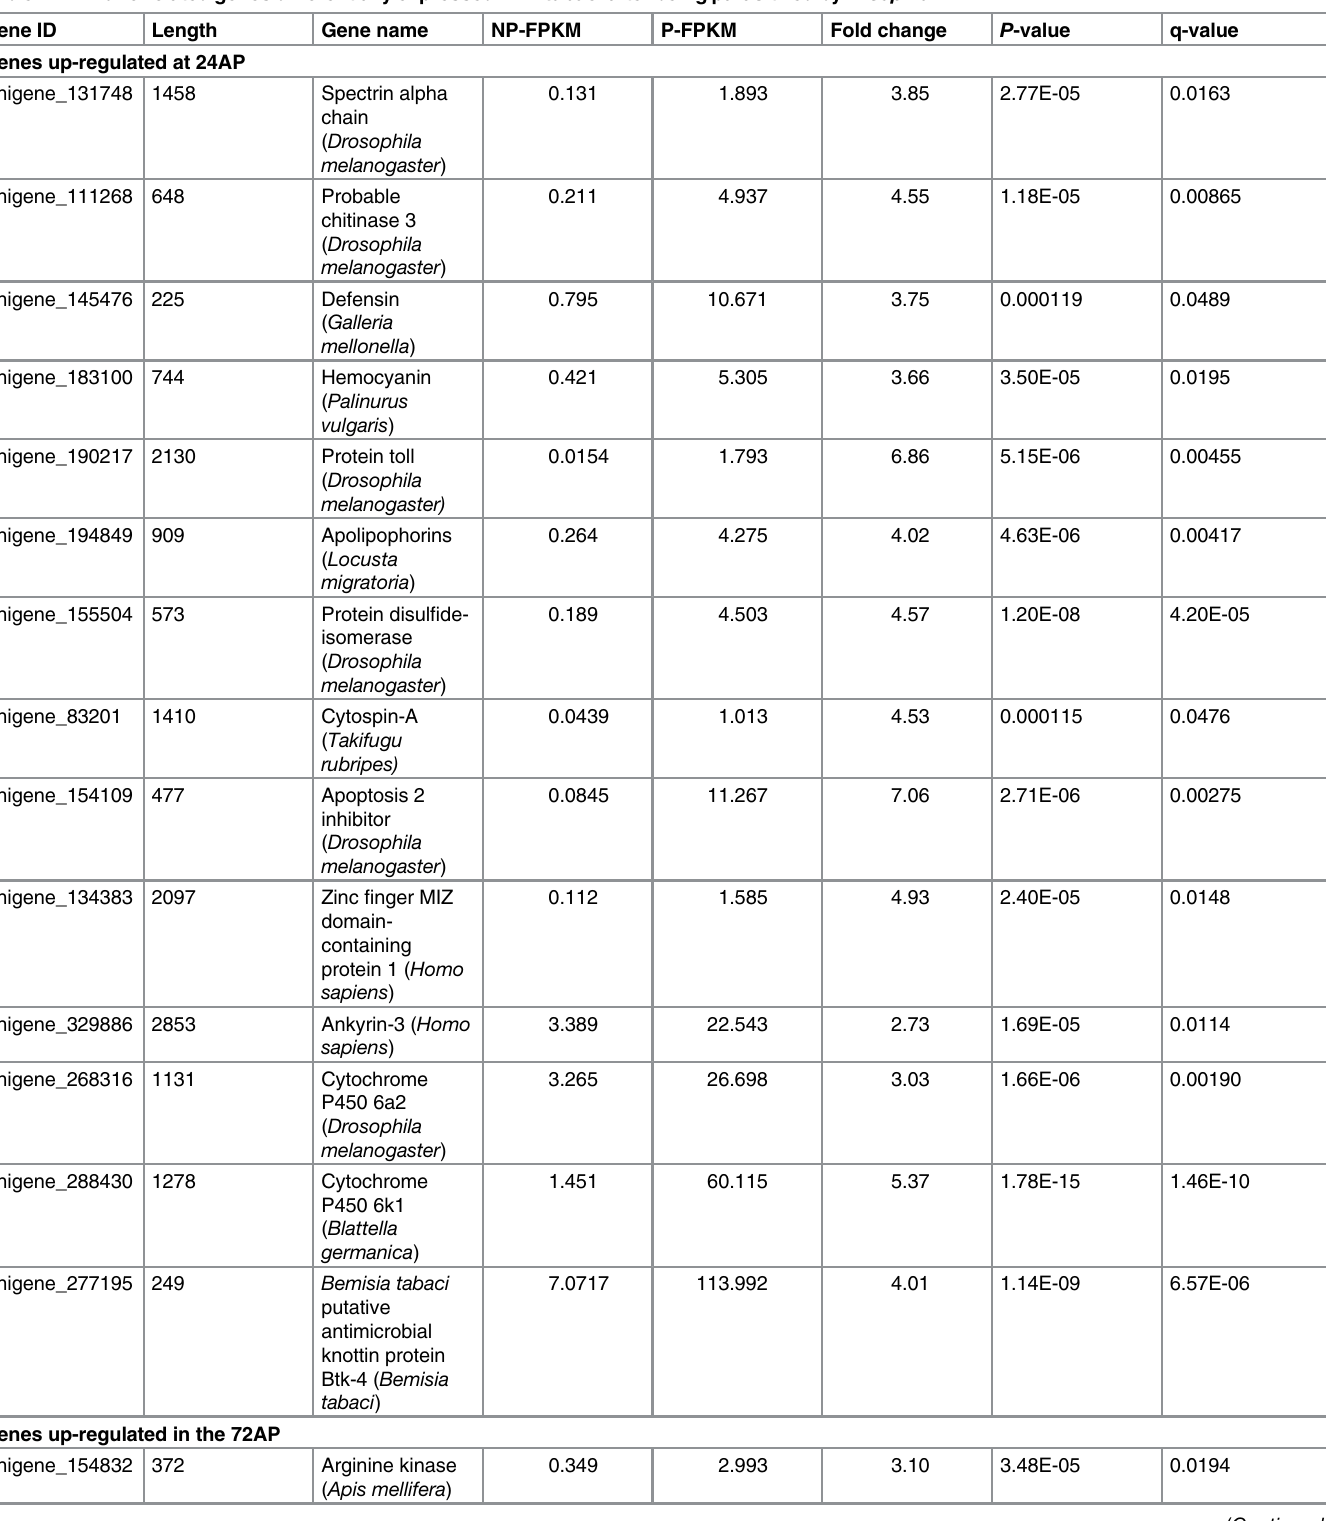
Table 1. Immune-related genes differentially expressed in B . tabaci after being parasitized by E . sophia